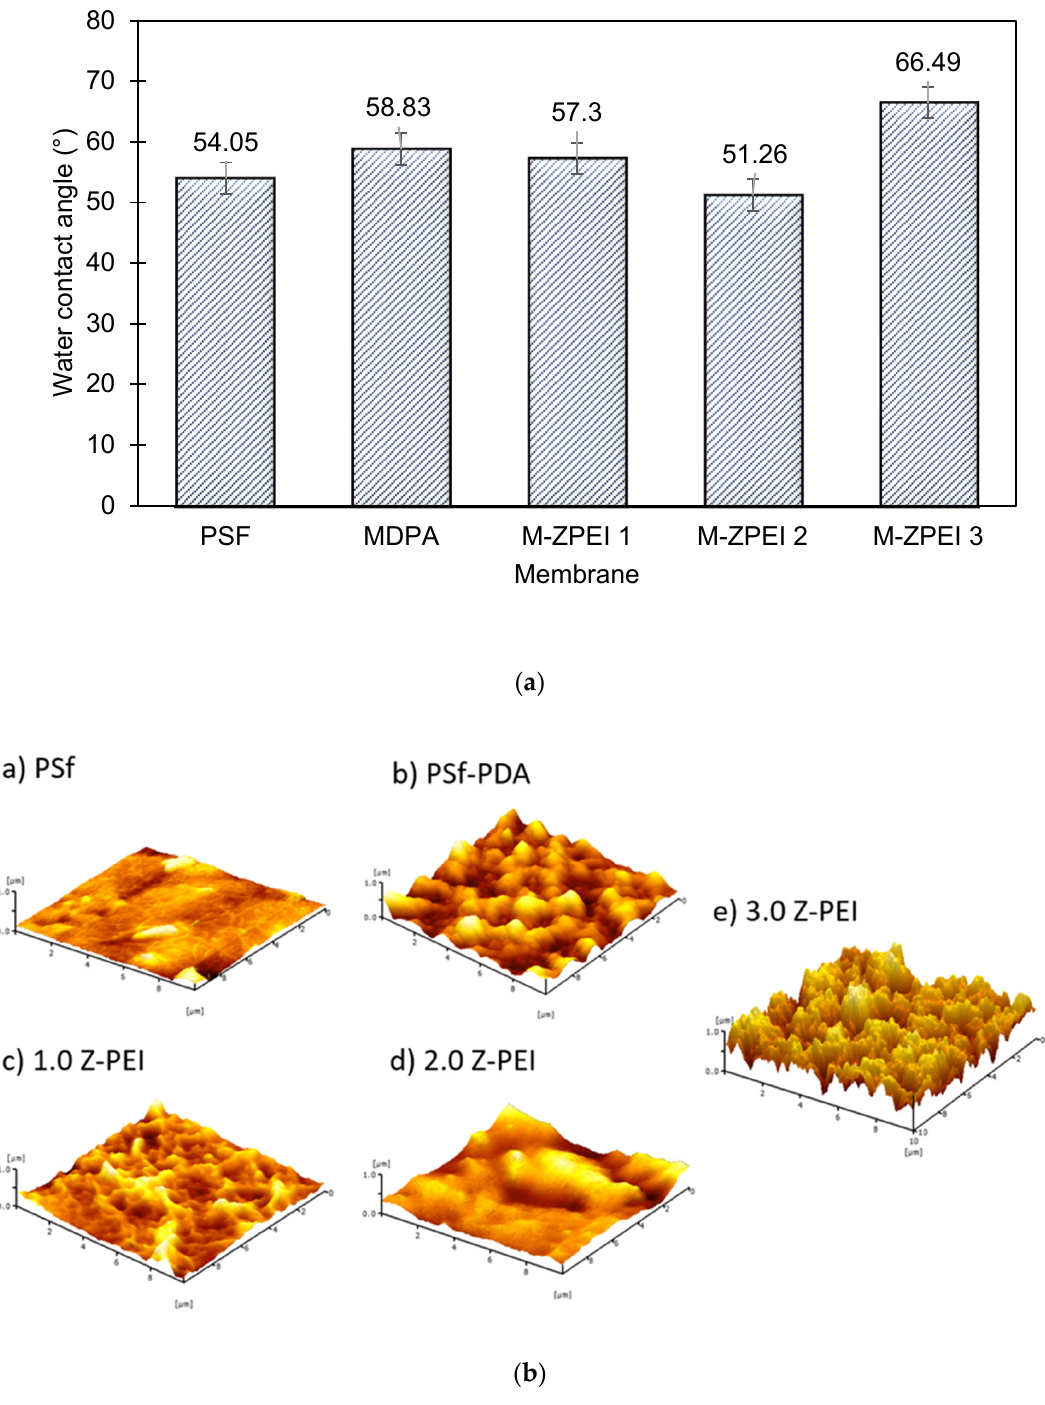
Figure 5. ( a ) Surface hydrophilicity of prepared membranes; and ( b ) membrane surface roughness images as indicated by AFM.